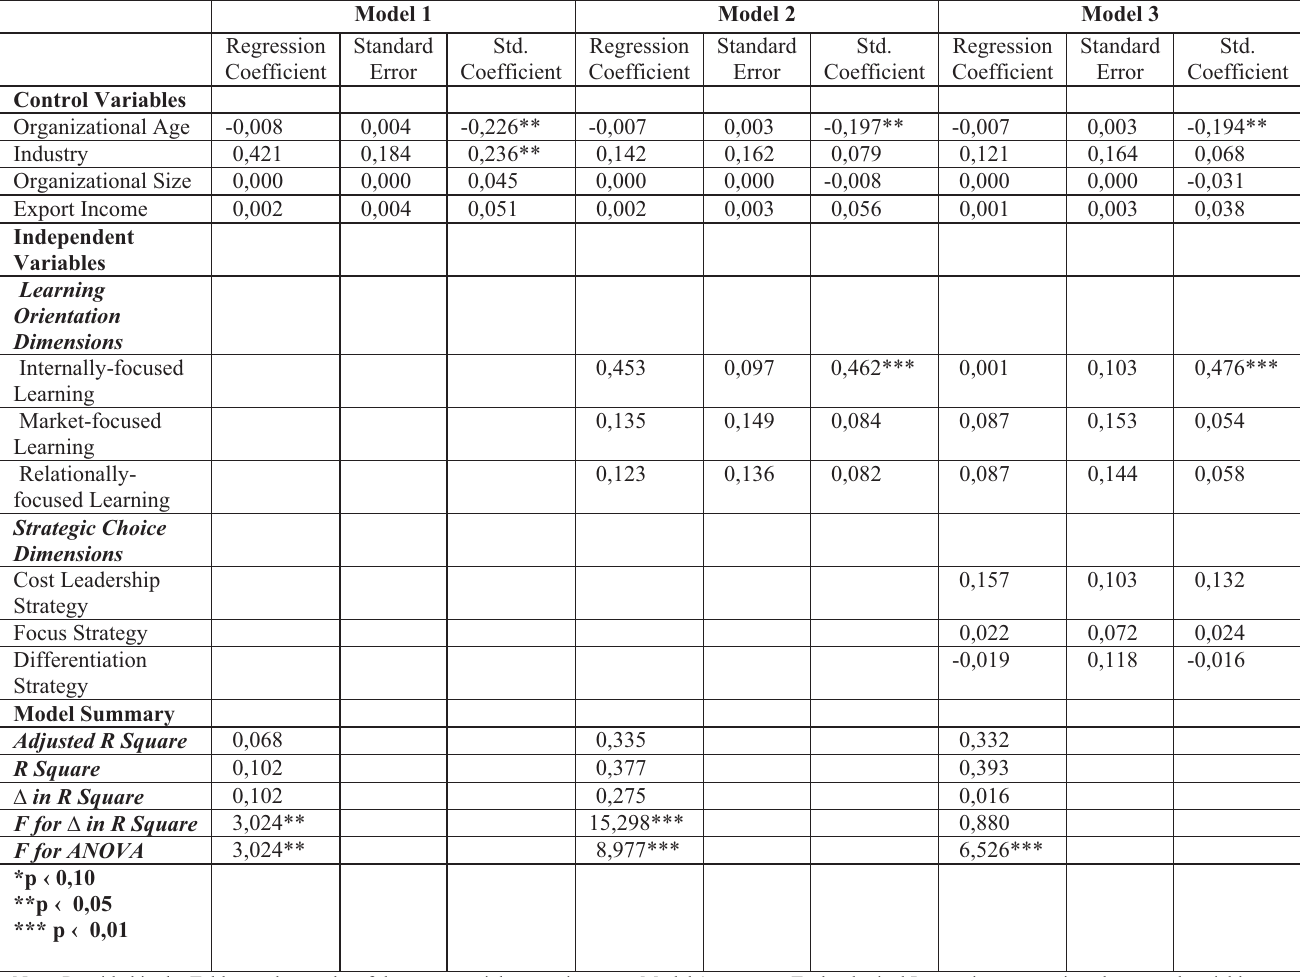
Table 5: Regression results for technological innovativeness Model 1 Regression